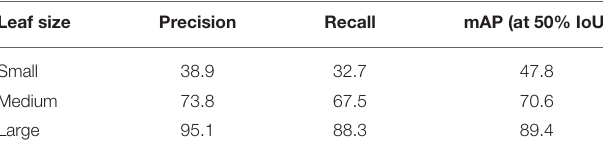
TABLE 4 | Comparisons of our model performance on different leaf size sub-dataset (in %). Leaf size Precision Recall mAP (at 50% IoU)